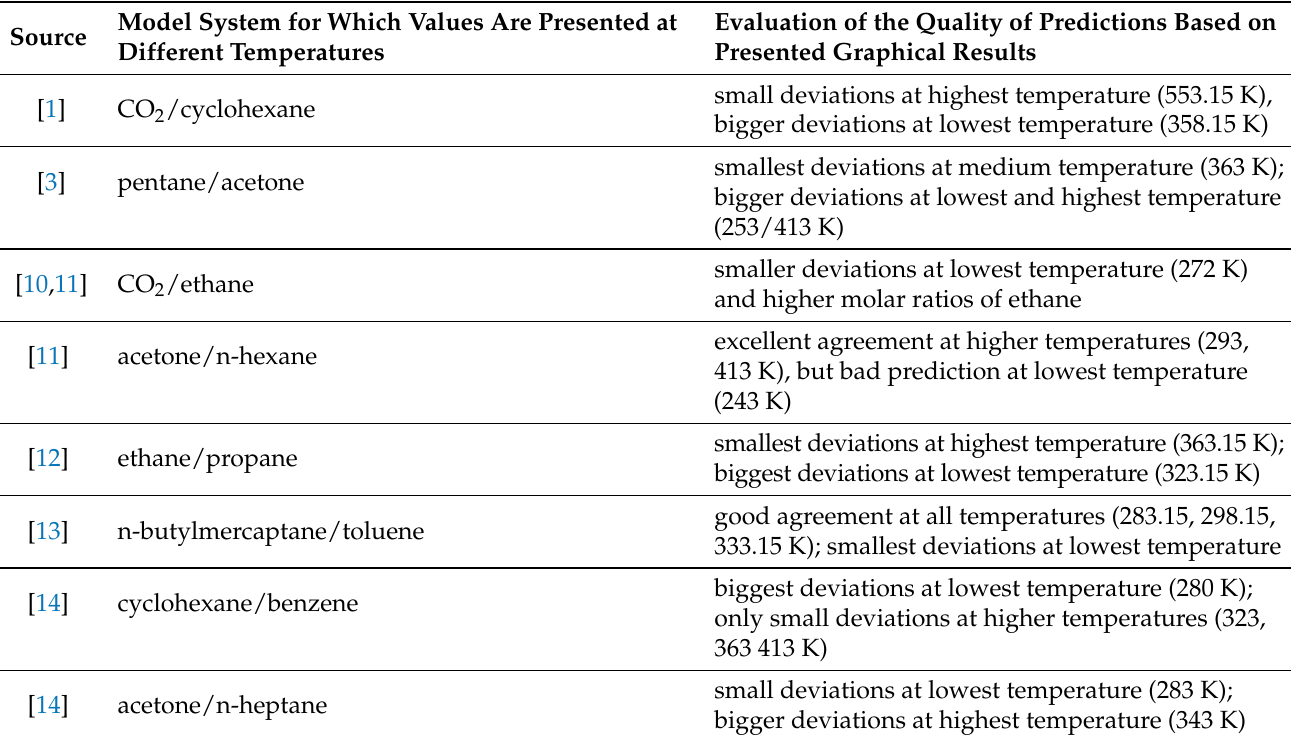
Table 1. Literature results for predictions of excess enthalpy at different temperatures using VTPR EOS.